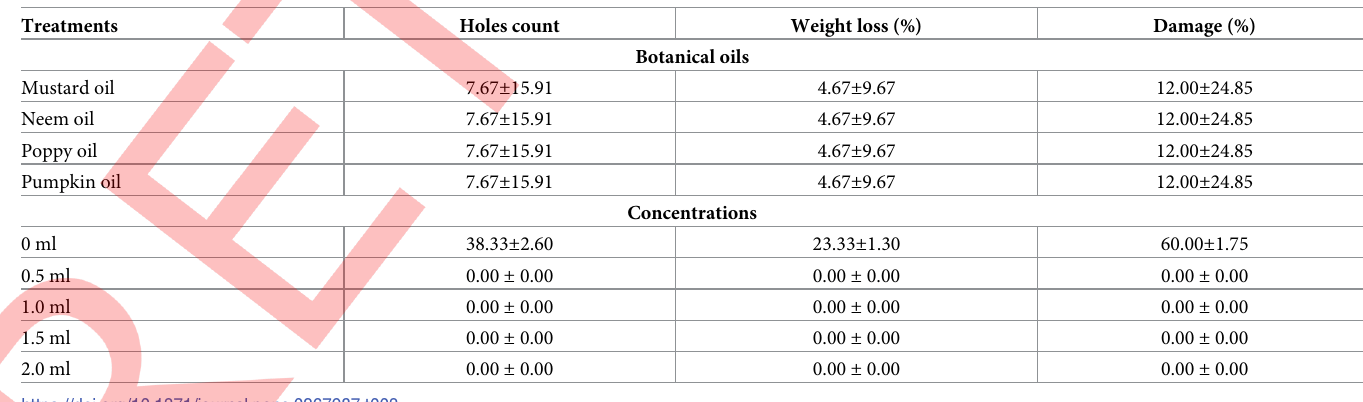
Table 3. The impact of different botanical oils and their concentrations on holes count, weight loss % and damage % of C . maculatus . Treatments Holes